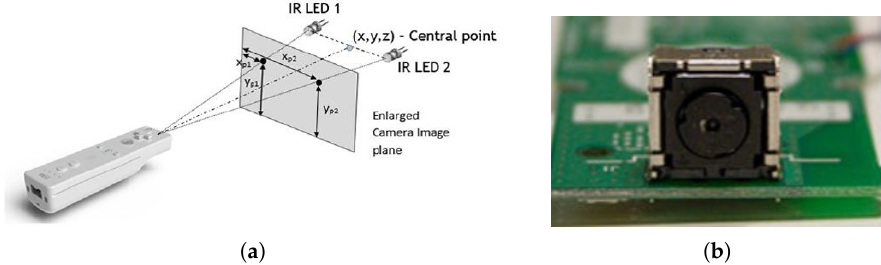
Figure 1. Wiimote with an Camera Image Plane ( a ) and the Camera Module ( b